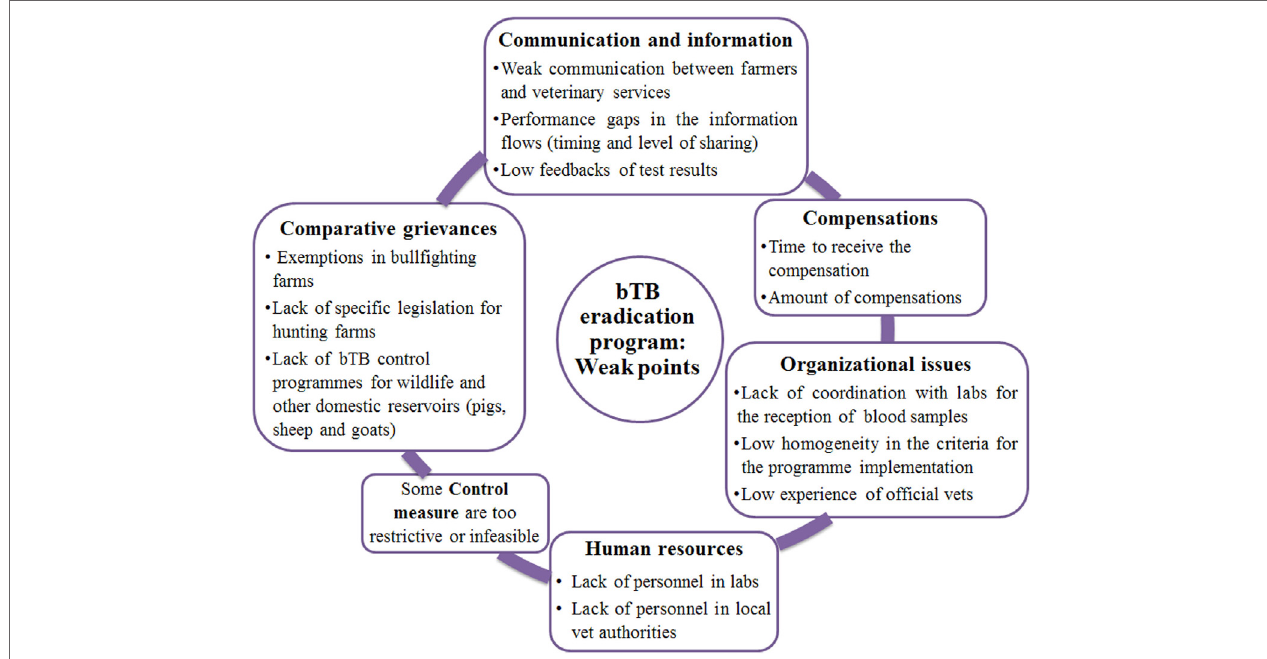
FigUre 3 | Schematic representations of the main themes emerged from exploratory interviews as “Weak points of the bTB eradication program”; results for Andalusia and Catalonia are presented together. “vets” = veterinarians; “labs” = diagnostic laboratories.